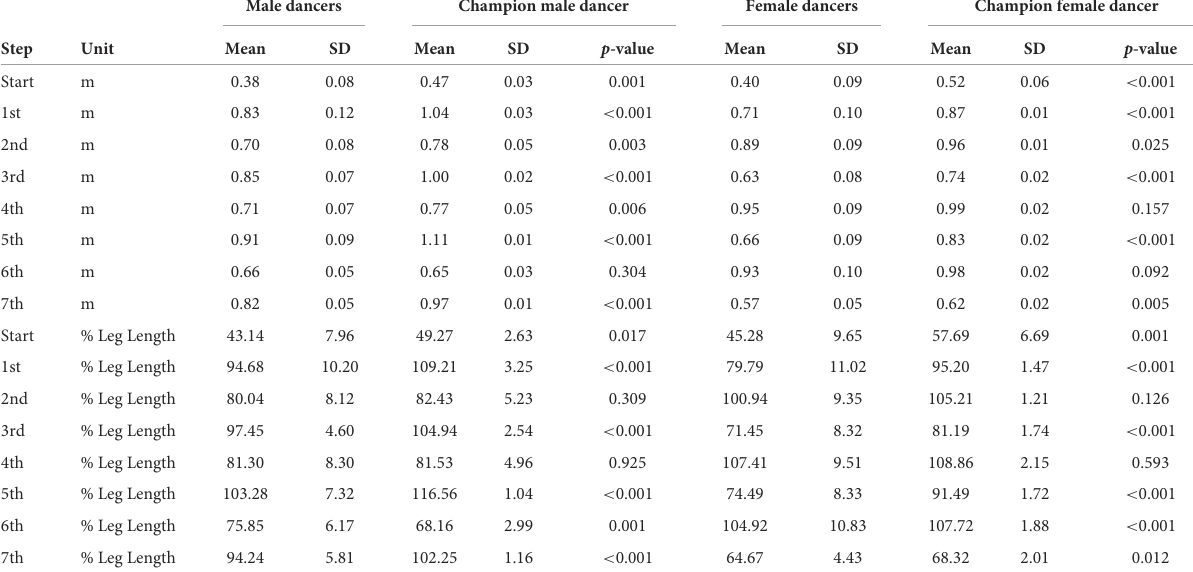
TABLE 1 Absolute and normalized start to seventh step lengths of the champion male and female dancers and the control group male and female dancers during the spin movement. Male dancers Champion male dancer Female dancers Champion female